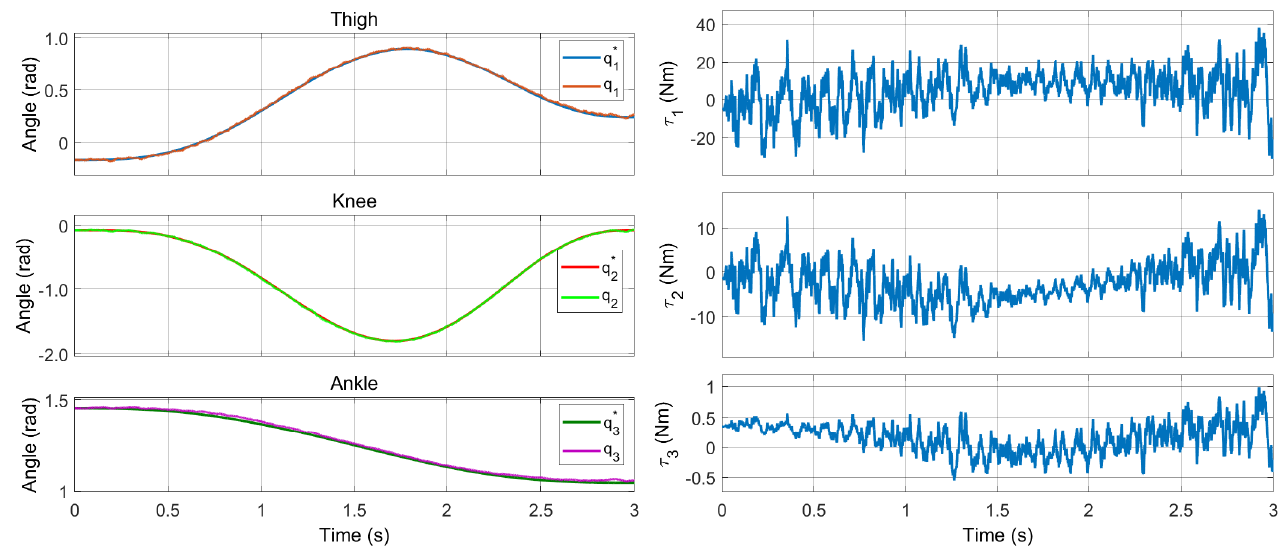
Figure 8. Nonlinear control for trajectory tracking.